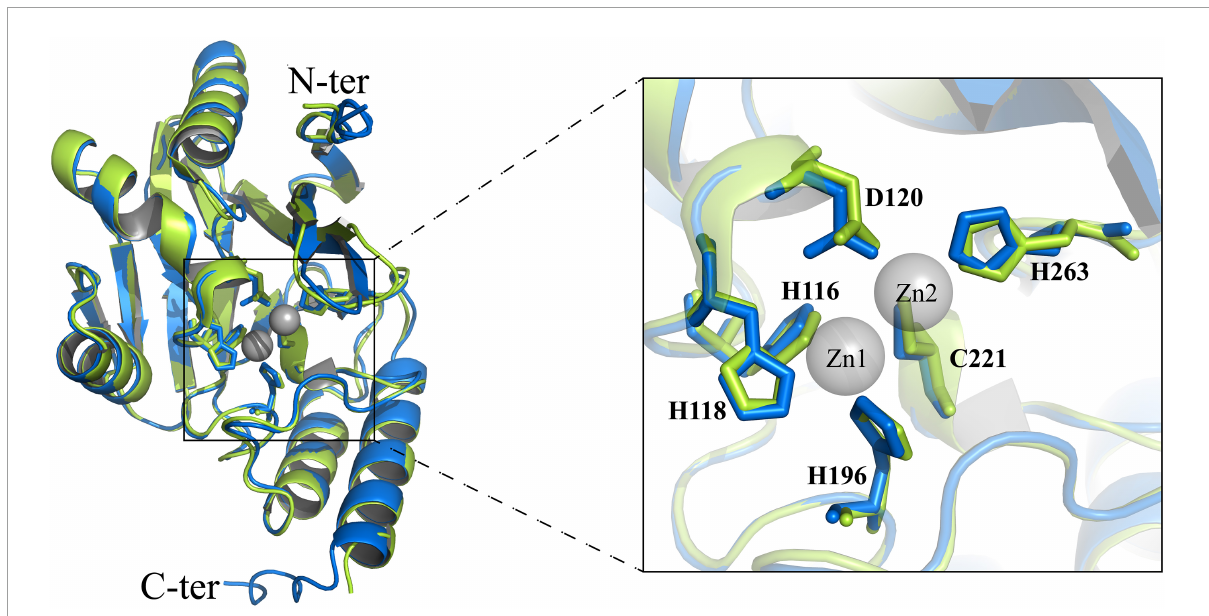
FIGURE4 Structural analysis of the zinc-dependent active site of SZM-1. Structural comparison of active sites between IMP-1 (green) and SZM-1 (blue). The key residues (according to the standard MBL numbering system) involved in the coordination of the zinc iron are marked. The two zinc ions of the active site are marked by gray color.